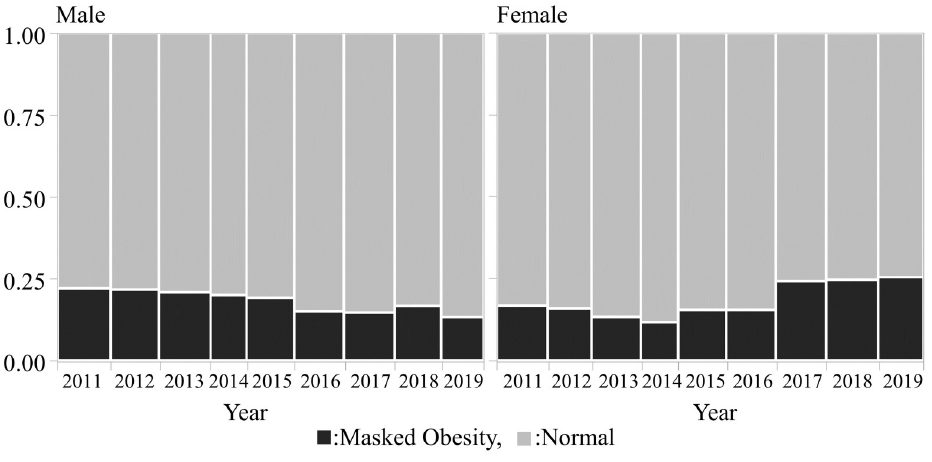
Fig 1. The change over time in the proportion of masked obesity in male and female students between 2011 and